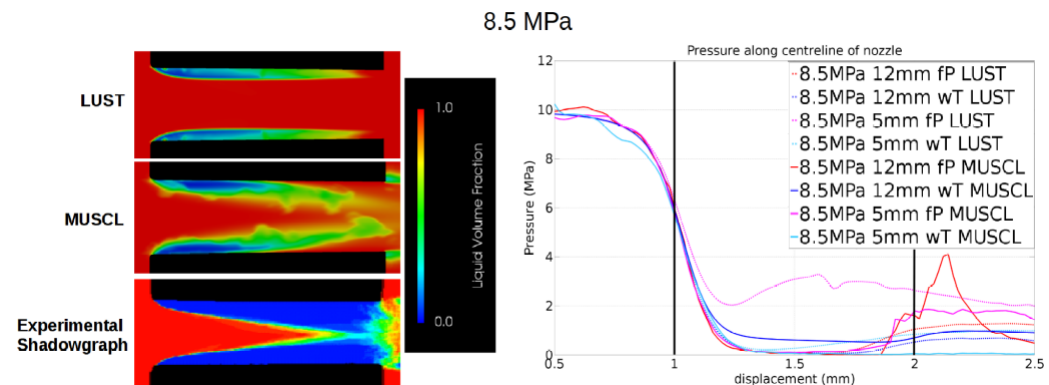
Figure 7. The data correspond to p dif f = 8.5 MPa, 12 mm computational exit chamber length. Left : Contour plots of the simulated vapour fraction, as well as shadowgraph pictures from the experiment [11]. Right : Pressure profiles along the centreline of the nozzle. The notation wT and fP corresponds to the wave transmissive and fixed pressure boundary conditions respectively. The two vertical black lines denote the nozzle entry and exit